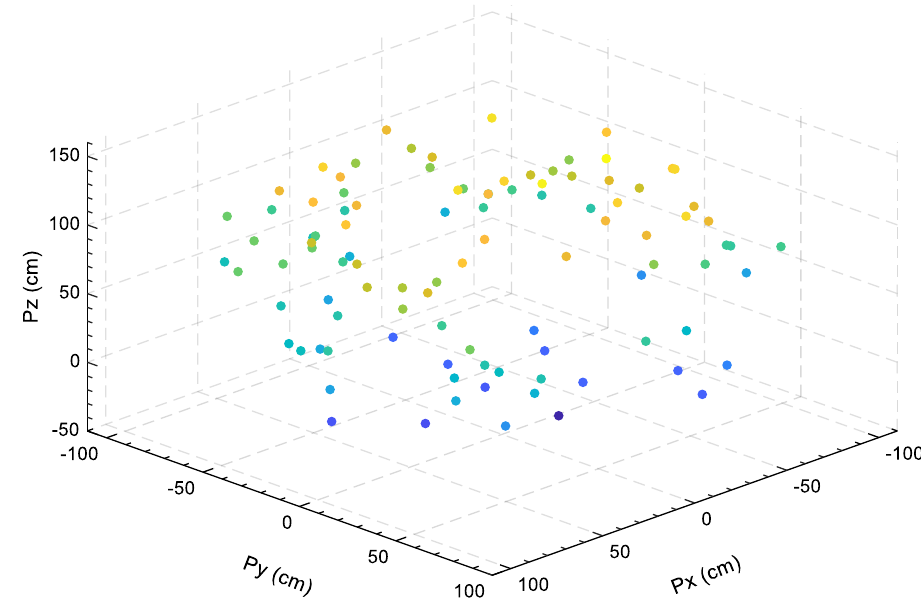
Figure 7. Randomly selected position points in the workspace of the manipulator.